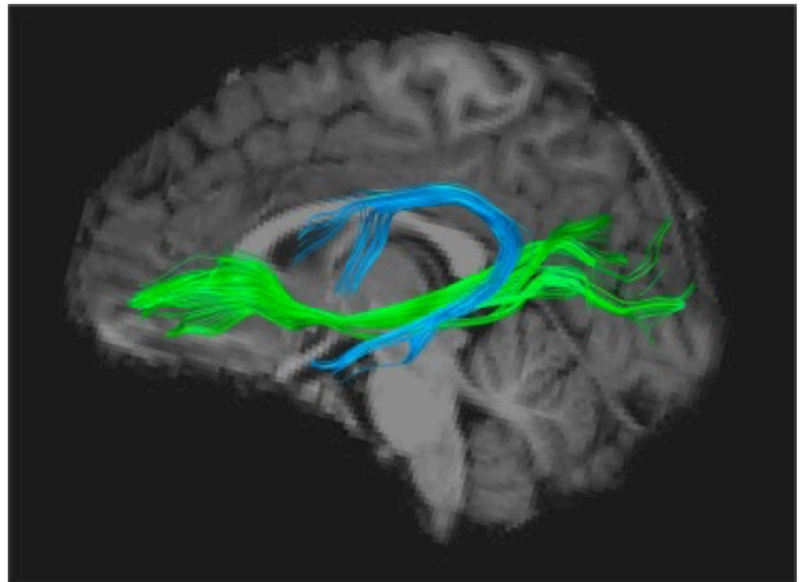
Figure 2. The two main white matter tracts usually reported as abnormally organized in the dyslexic brain: arcuate fasciculus (AF, in blue) and inferior fronto-occipital fasciculus (IFOF, in green), respectively associated with phonological and orthographic scores on standardized tests [29,33]